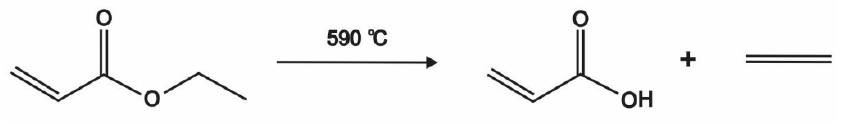
Figure 1. The chemical formula of the pyrolysis process.